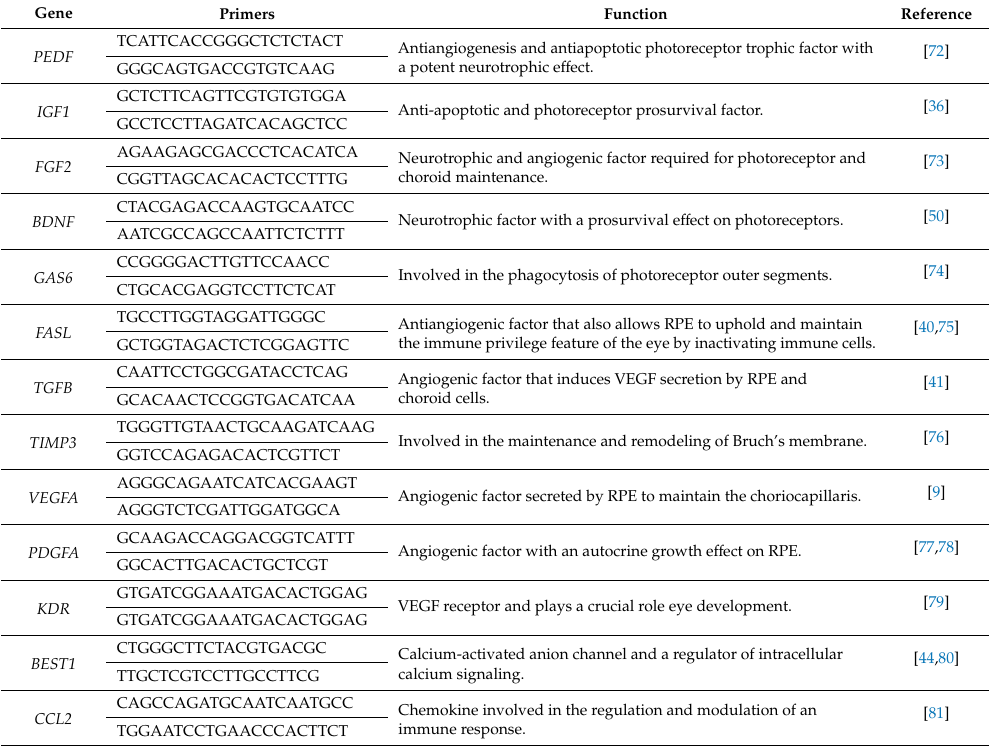
Table A1. RT-qPCR primers chosen to evaluate the functions of human